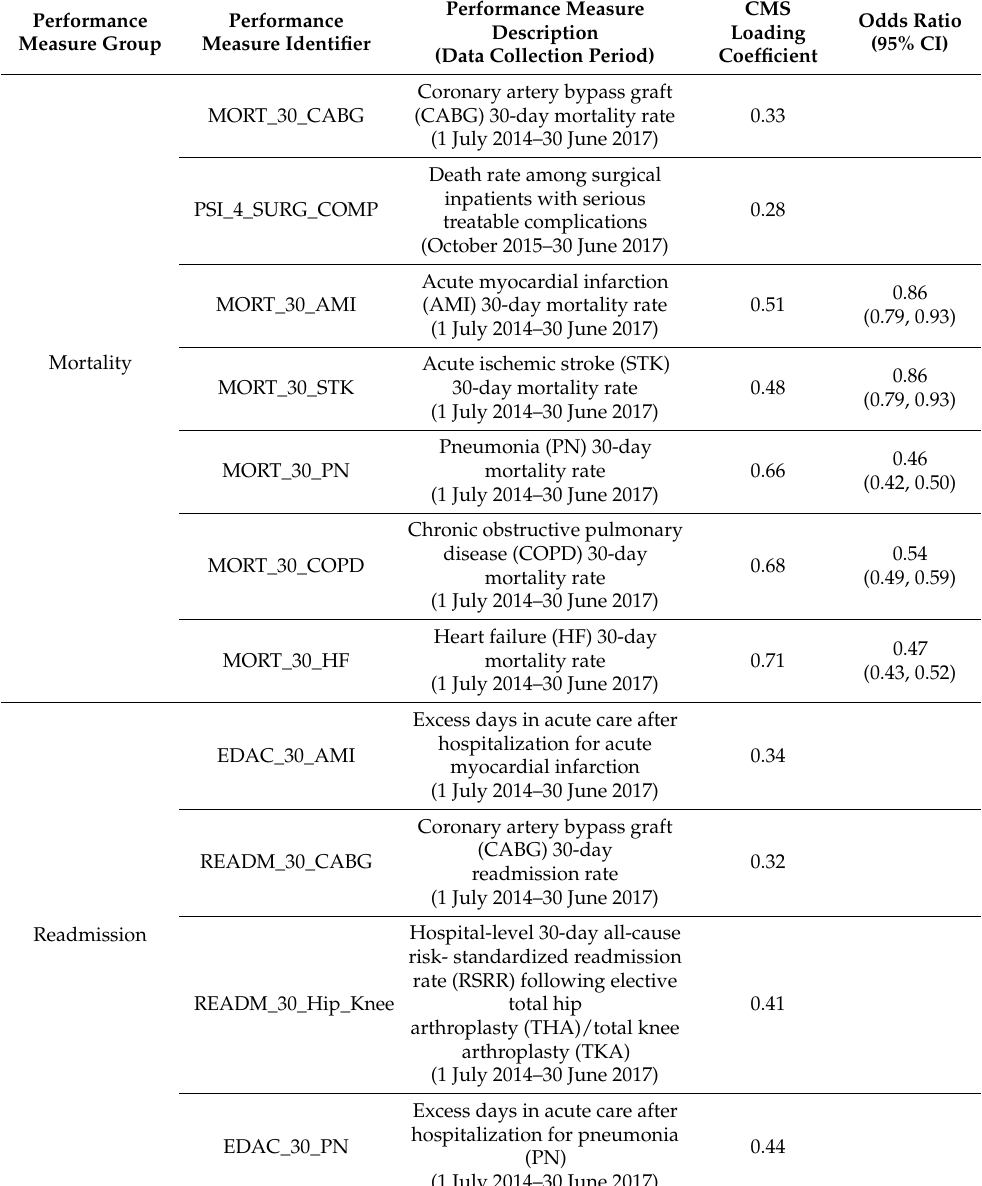
Table 3. Relative comparison of CMS model with the ordinal logistic regression